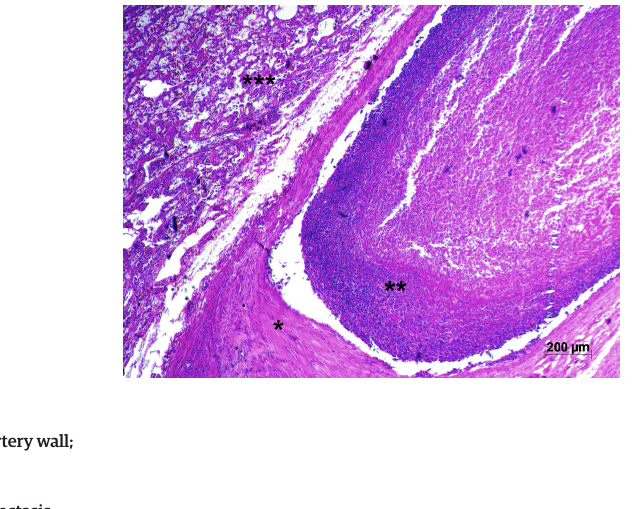
Figure 8. Lung of the dog which died due to heartworm infection showing thickening of an artery wall, a thrombus attached and villous projection. Extensive necrosis area adjacent to the artery.